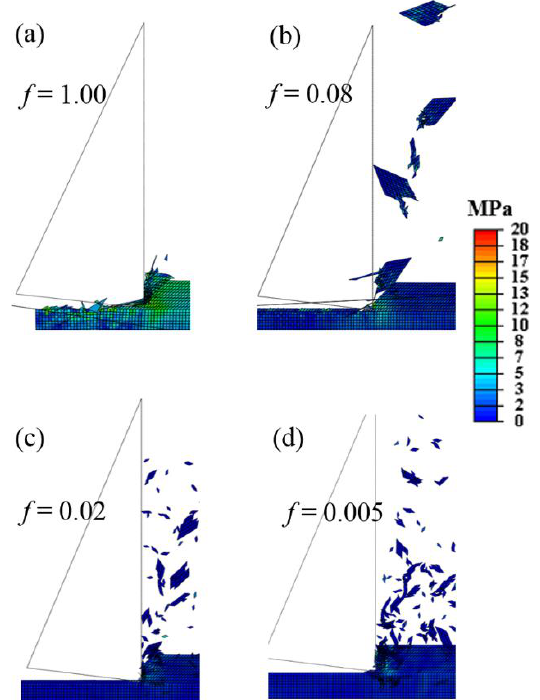
Figure 4. Material responses to the cutting tool with different scaling factors: ( a ) f = 1, ( b ) f = 0.08, ( c ) f = 0.02, and ( d ) f = 0.005. The stress is based on the testing material 30 pcf.